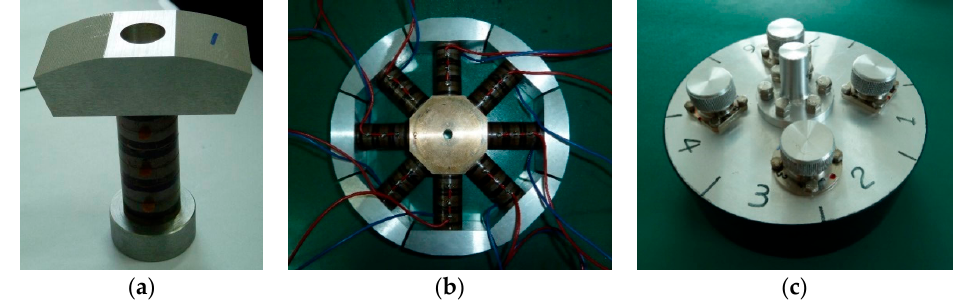
Figure 11. ( a ) A single LVPE; ( b ) the internal structure of the transducer prototype. All parts of the transducer were bonded with epoxy resin; ( c ) the transducer prototype after watertight encapsulation with polyurethane.